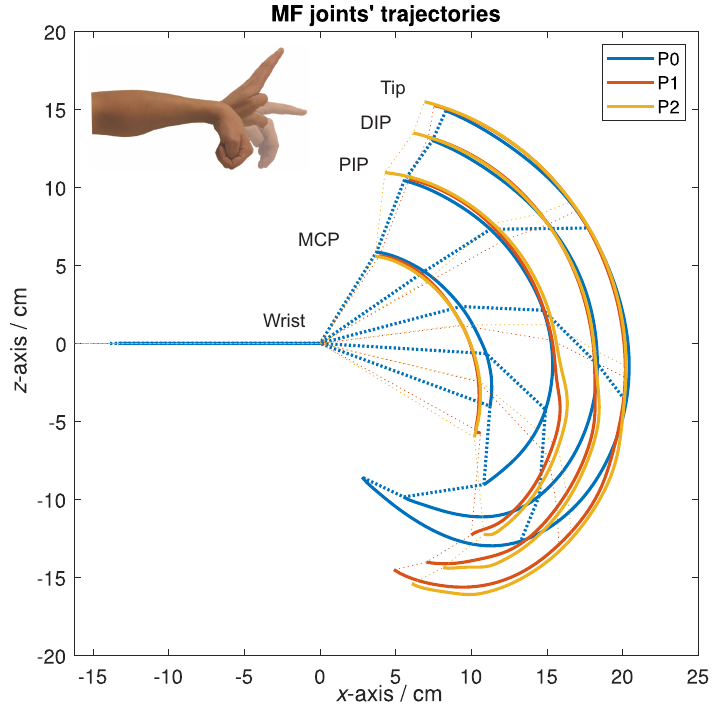
Figure 8. The MF joints’ trajectories in the sagittal plane for one of the subjects and all three experi- mental protocols: P0—blue, P1—red, and